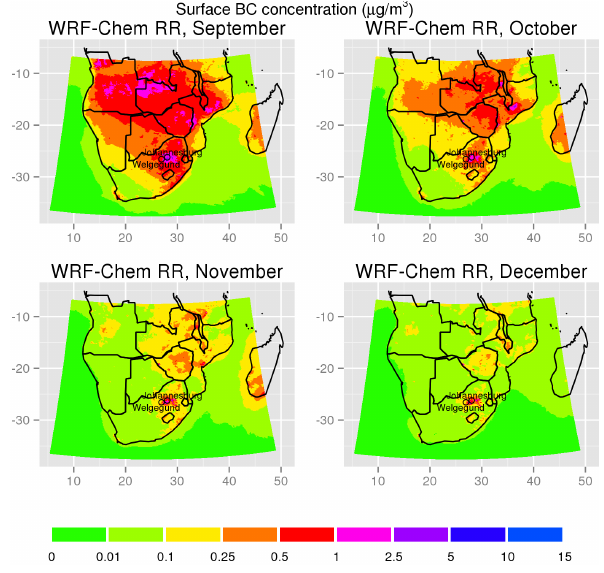
Figure 5. Monthly mean near-surface BC concentrations (lowest model layer) modeled with WRF-Chem, September– December 2010.